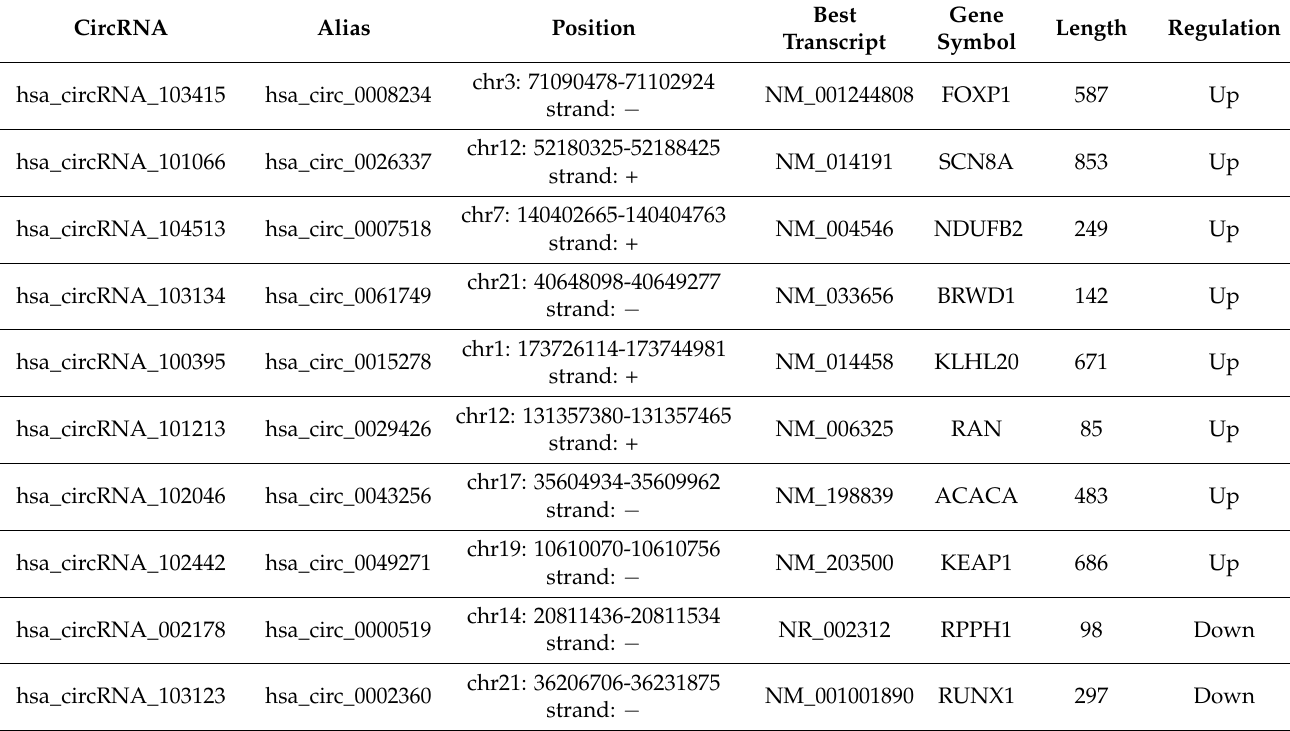
Table 2. Differentially expressed circRNAs that overlapped in all above-described GEO